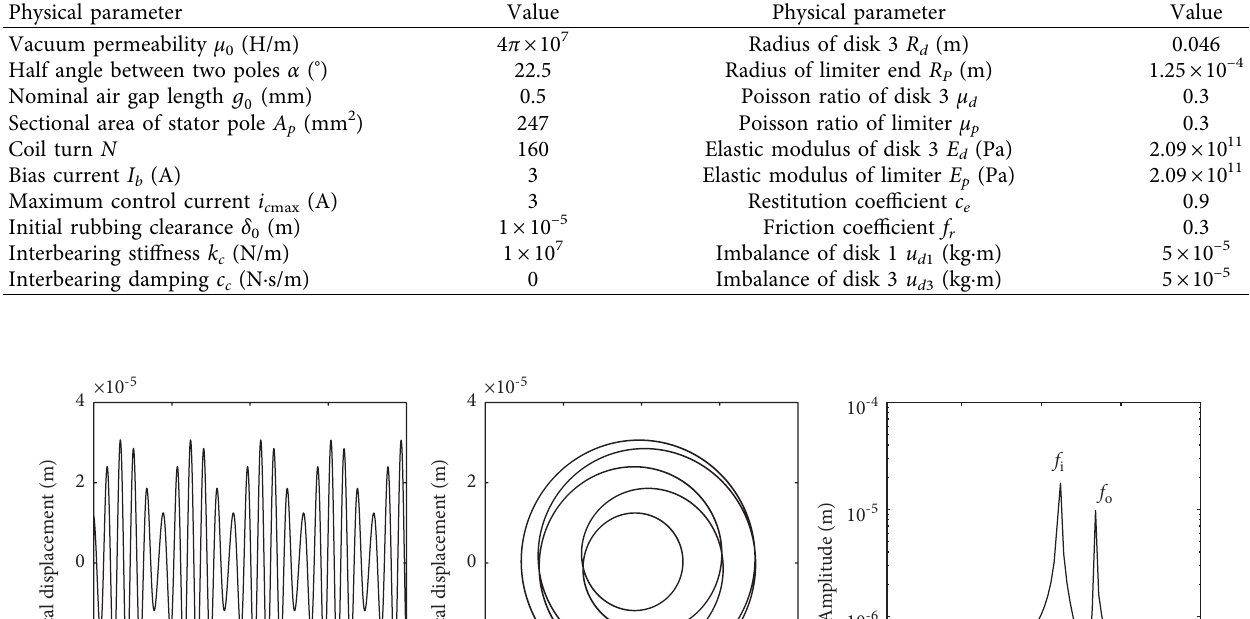
Table 2: The main parameters of the MSDS.